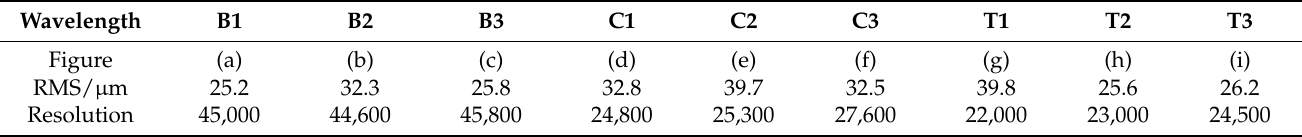
Table 6. RMS and spectral resolution of multiple